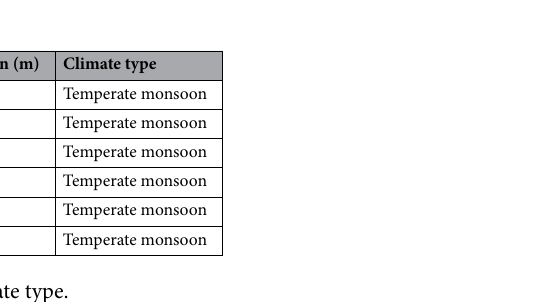
Figure 1. Location of study area. (China and Shandong Province data from Ministry of Natural Resources of China, http:// www. mnr. gov. cn/; Jinan City and Hancang River Basin was generated by ArcGIS 10.3 software, https:// deskt op. arcgis. com/ en/).